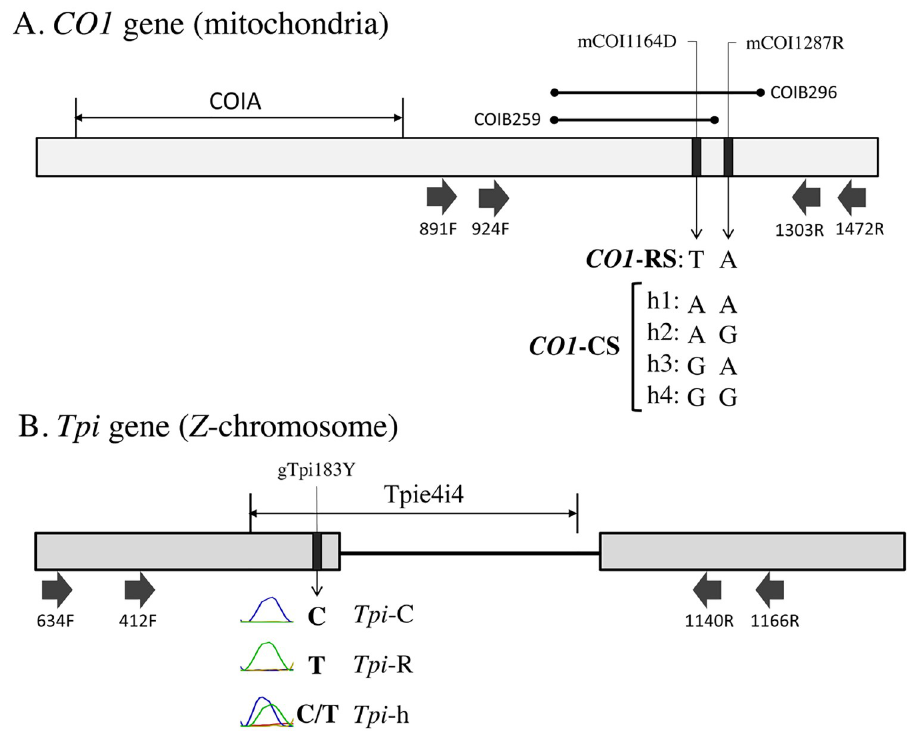
Fig 1. Diagrams of the COIB, Tpi gene segments. A. The COI gene showing the locations of the COIA segment frequently used for DNA barcoding and the COIB segments used in this study. The mCOI1164D site defines COI- based strain identity and together with polymorphisms at mCOI1287R describe the corn-strain h1-4 haplotypes. Black arrows indicate locations of primers used for PCR and DNA sequencing. B. Map of a section of the Z-linked Tpi gene that includes exon4 (fourth exon from the start of the coding region), exon5 and the intervening intron. The gTpi183Y site defines Tpi-based strain identity with the empirically observed sequence chromatographs shown indicating the C, T, C/T heterozygote forms found in this study. The Tpie4i4 contains a portion of exon4 and intron4.